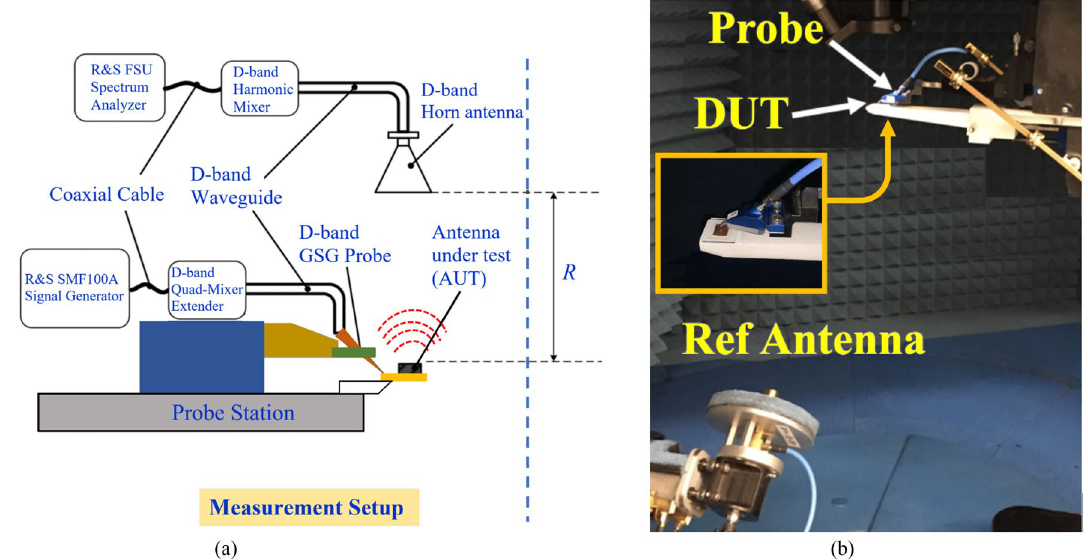
Figure 3. ( a ) Diagram of the antenna-on-chip (AoC) wafer measurement setup, and ( b ) Photograph of the AoC gain measurement setup.